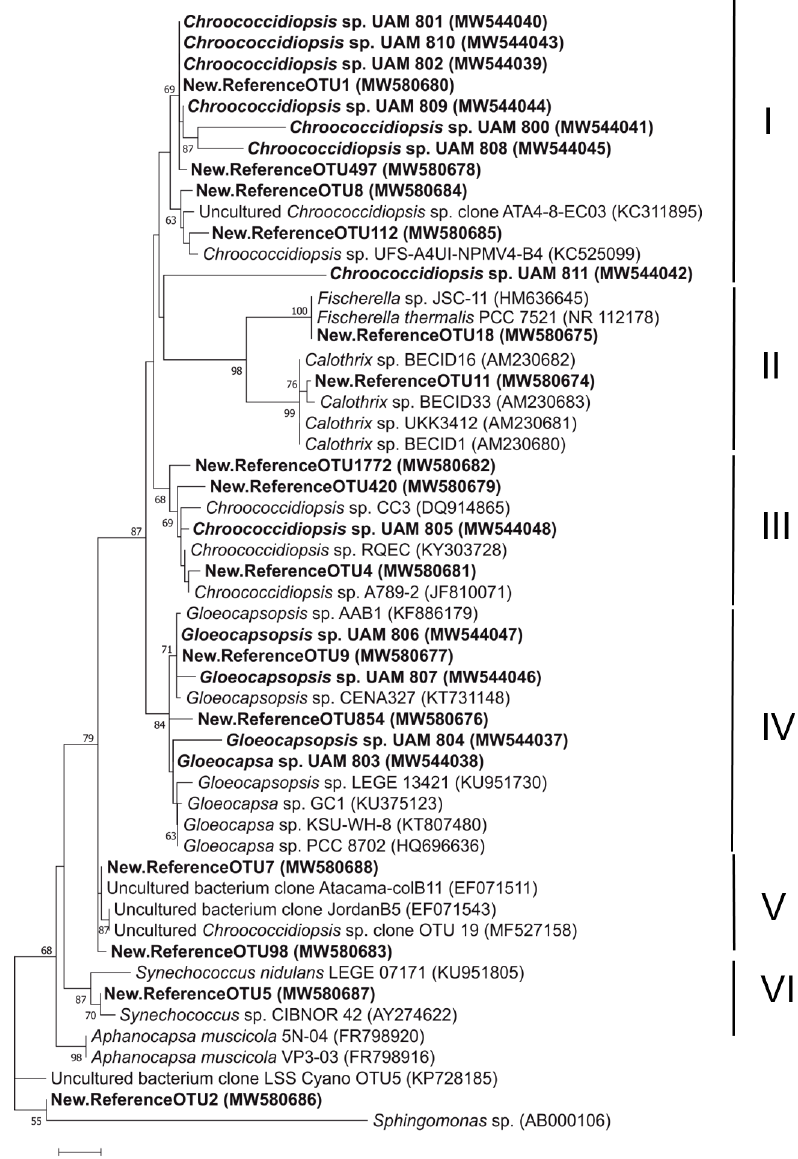
Figure 5. Maximum likelihood tree based on partial 16S rRNA sequences of Cyanobacteria OTUs above 1% relative abundance and cyanobacterial strains isolated from the three gypcrete microhabitats. Bold indicates sequences from this study. Scale bar indicates 5% sequence